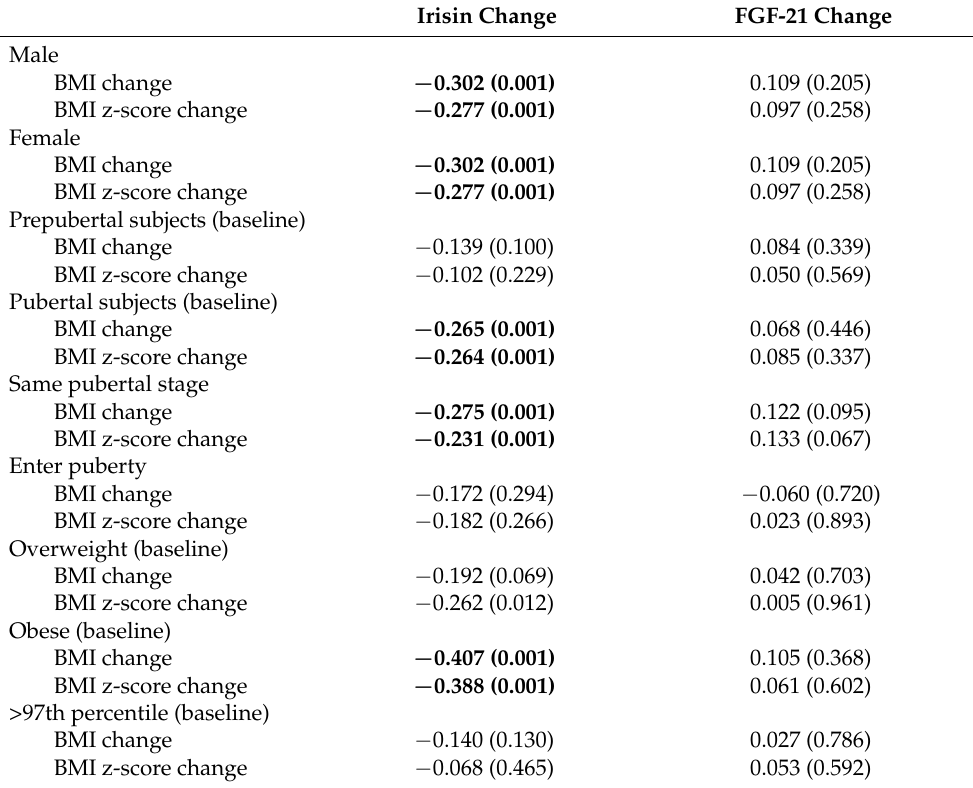
Table 4. Stratified correlations of Irisin and FGF-21 changes and BMI changes according to gender, pubertal status, and BMI